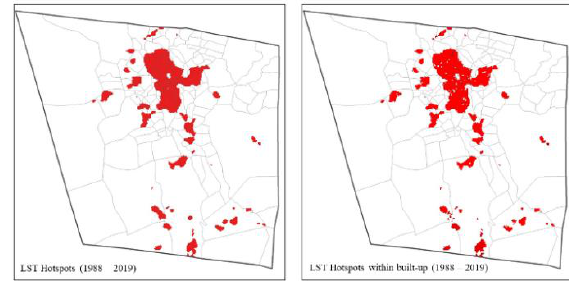
Figure 10. LST hotspots (left) and the LST hotspots that occur within the built-up areas (right) in Baguio City from 1998-2019